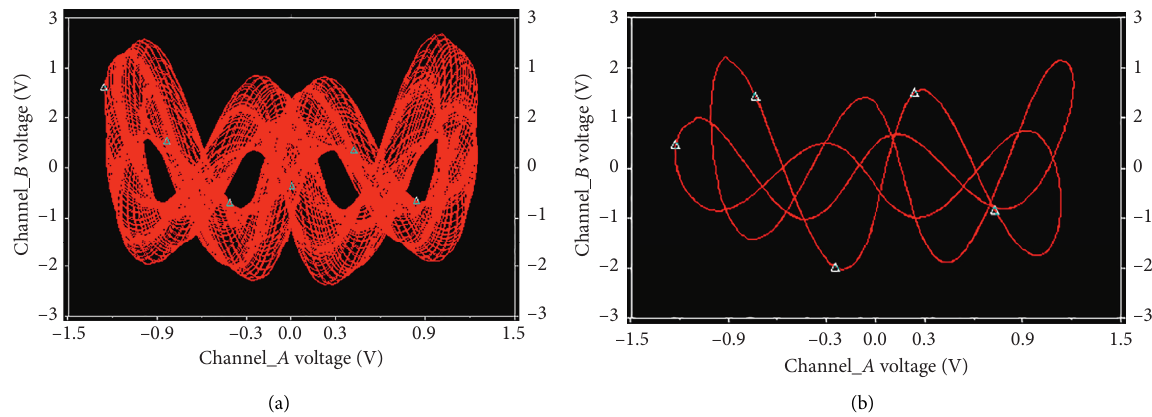
Figure 11: Circuit simulation results of rotationally symmetric chaotic flow with four-wing. (a) a �− 0.05, b � 1, c � 0.5, R 22 � 1.55k Ω . (b) a � − 0.05, b � 1, c � 0.5, R 22 � 1.53 k Ω